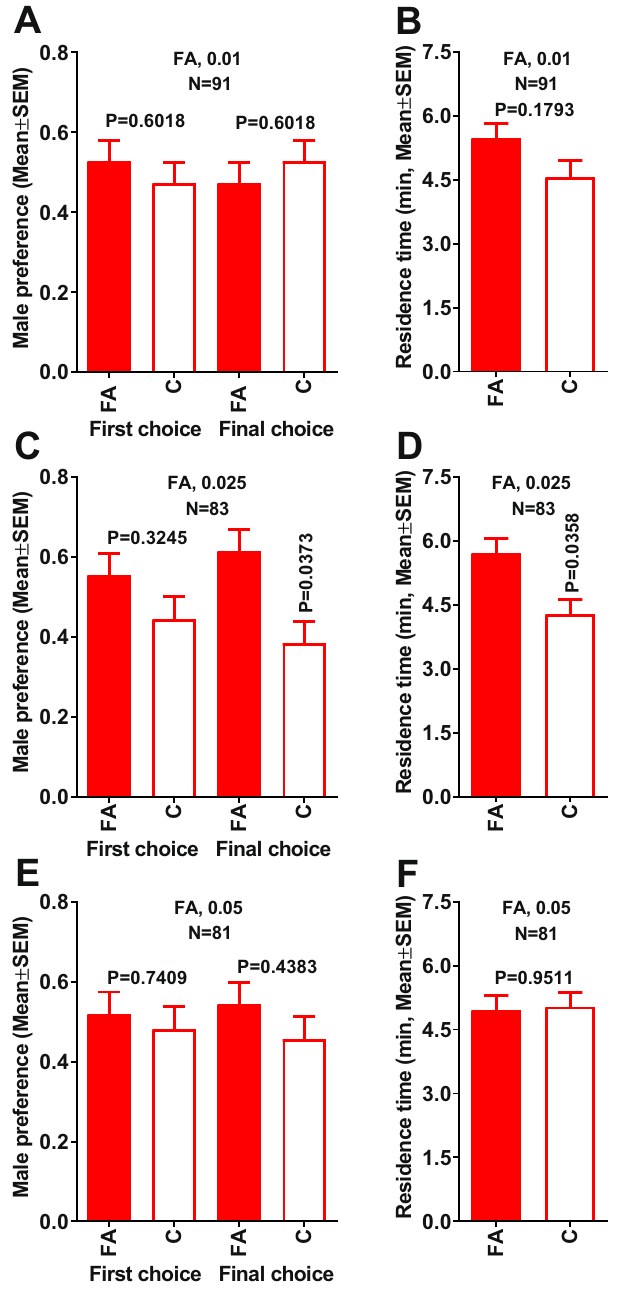
Figure 1. Behavioral responses of 7-day-old virgin males to formic acid in a 4-way olfactometer. Male first and final choices when comparing ( A ) 0.01, ( C ) 0.025, and ( E ) 0.05 µ g of formic acid with control. For consistency, all related figures are presented in increasing doses from top to bottom. Comparison of residence times in each treatment vs. control with formic acid at ( B ) 0.01, ( D ) 0.025, and ( F ) 0.05 µ g. Male preference indicates the proportion of males making first and final choice. Means were compared by Wilcoxon matched-pairs signed- rank tests. FA = formic